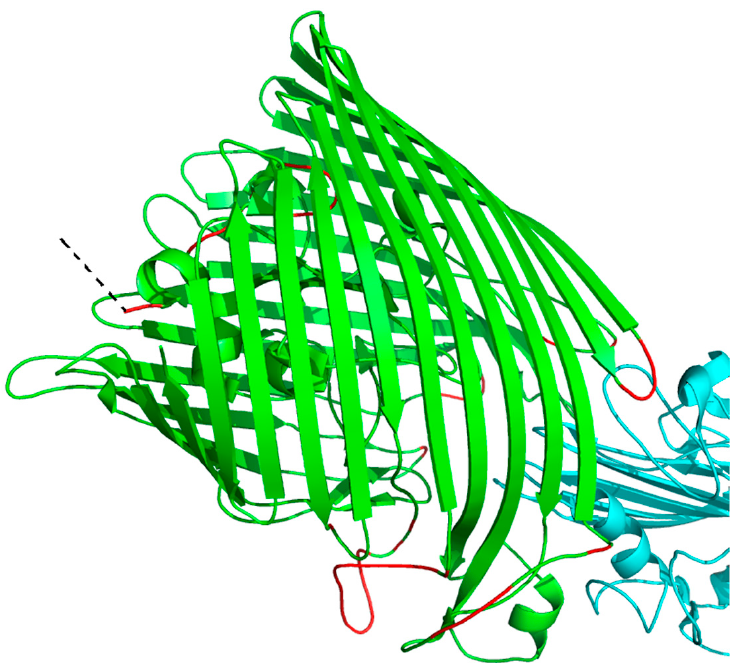
Figure 1. A schematic view of the target H1129 in CASP15 (PDBID:8A8C) with potentially disordered regions. The figure shows the three-dimensional structure of this protein. The potentially disordered regions are marked with red or dotted lines in the figure, where red regions represent the regions of the loop and are predicted to be disordered, and the dotted line represents the region with missing coordinates in the PDB structure and is predicted to be disordered.